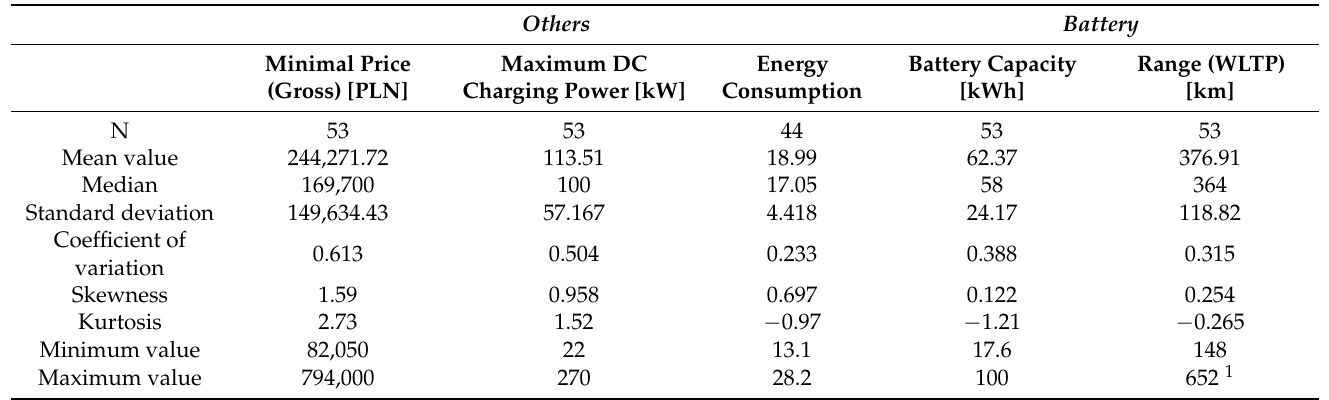
Table 2. Descriptive statistics for extracted groups— battery and others .